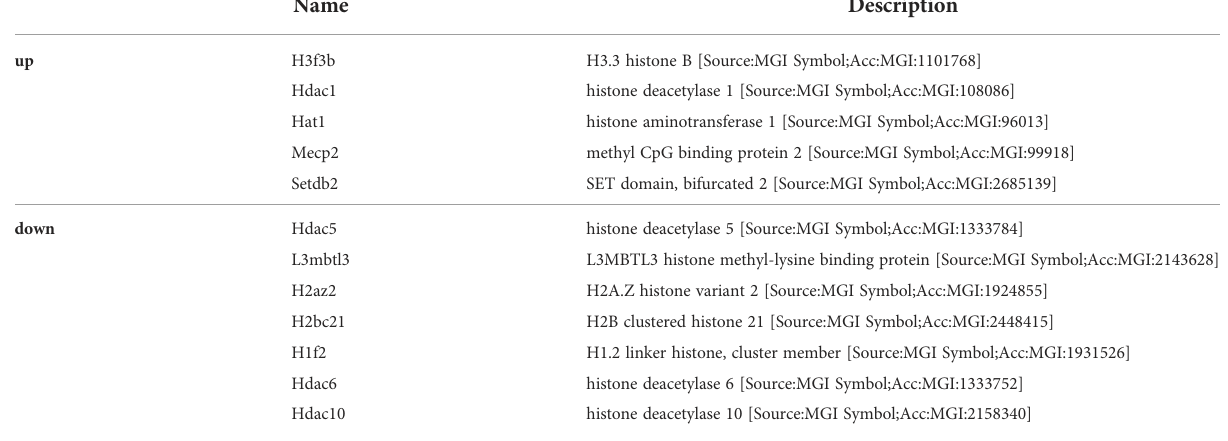
TABLE 3 Common DEGs involved in histone modi fi cations after two stimulations in BMDMs of MRL/lpr